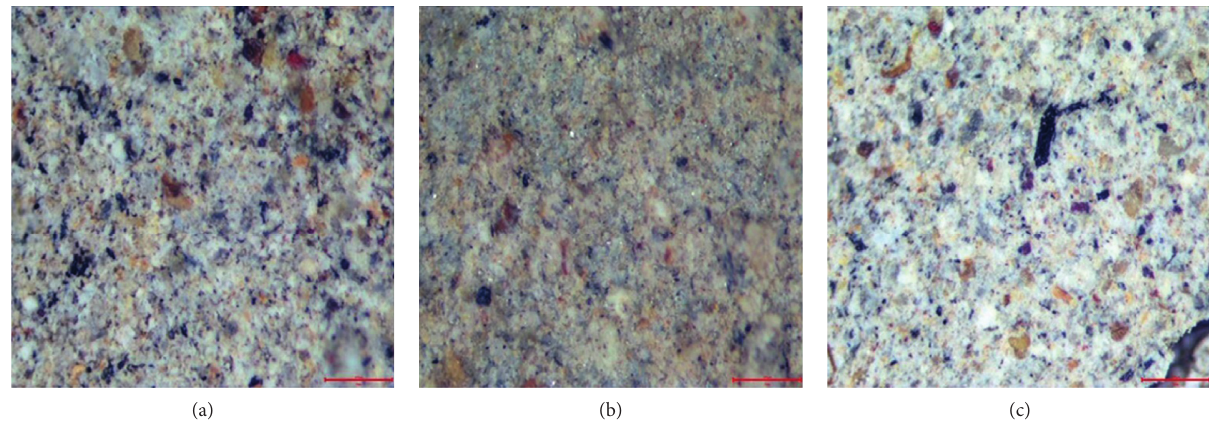
Figure 14: Microscopic structures of samples. (a) Top of samples 2–3 ( × 50). (b) Middle of sample 2–2 ( × 50). (c) Bottom of sample 2-1 ( × 50).